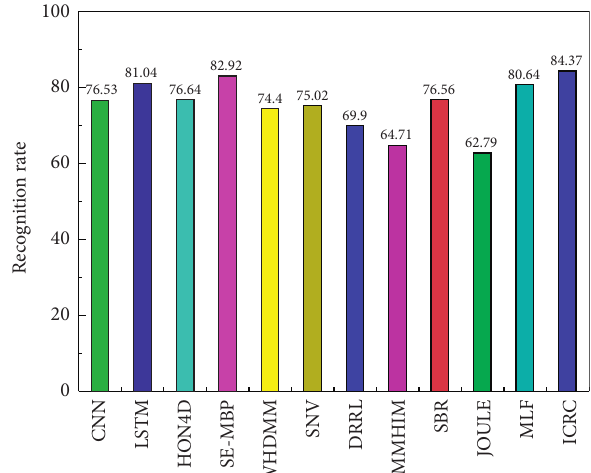
Figure 7: Comparison of algorithms with existing research work.